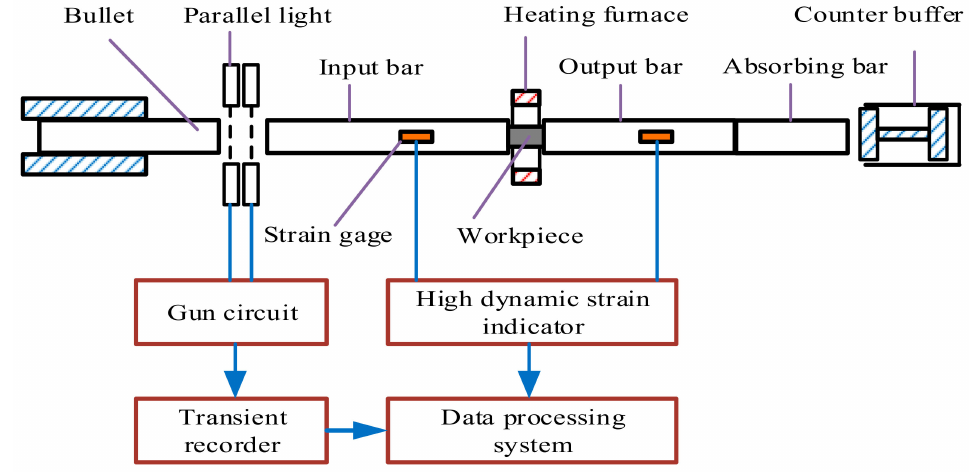
Figure 1. Schematic of high temperature SHPB